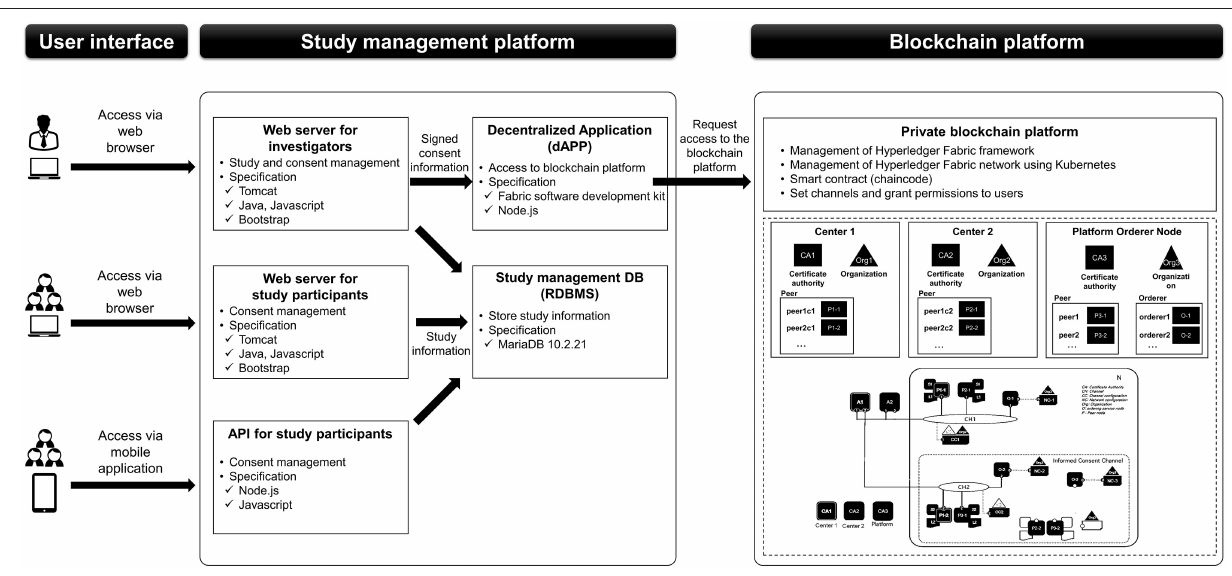
FIGURE 2 | Data flow and architecture of the